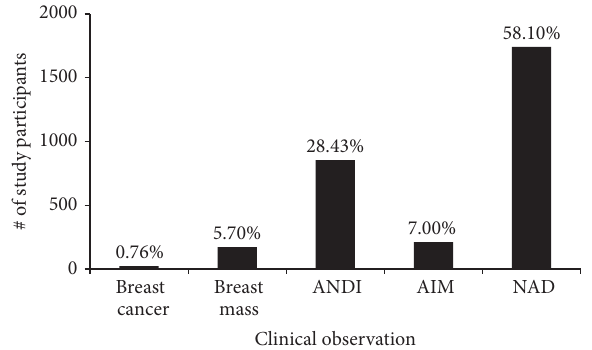
Figure 8: Overall summary of incidence of breast lesions. Various percentages of breast lesion incidences are shown. ANDI: Aber- rations of Normal Development and Involution; AIM: Abscesses, Infections, and Mastitis; and NAD: No Abnormalities Detected. The incidence of breast cancer in Ghana is 0.76%, which is predicted to increase with